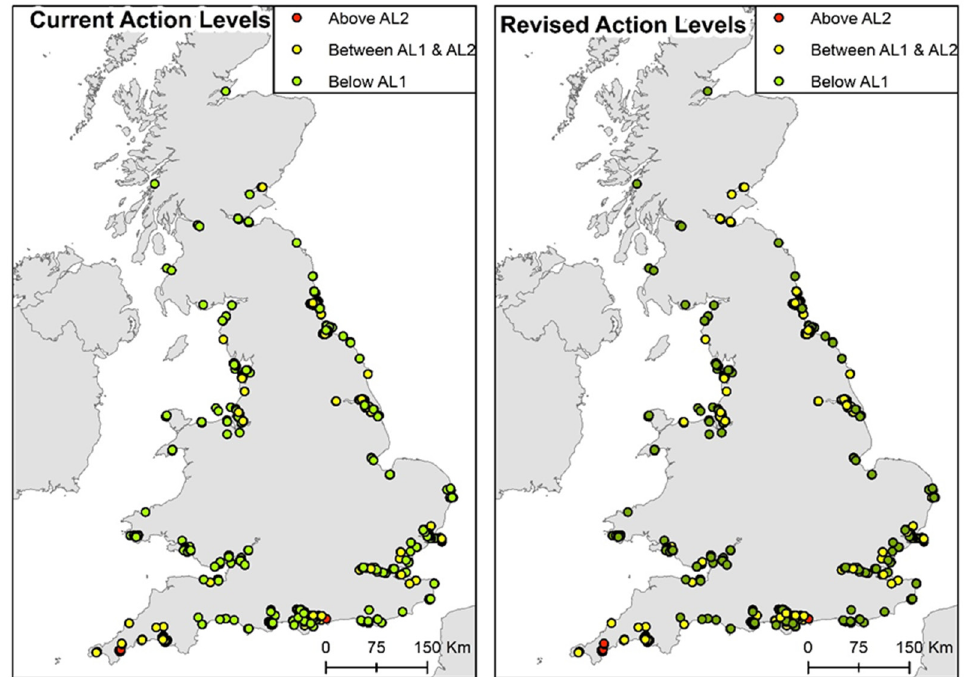
Figure 2. Maps showing the differences between the current ALs and revised ALs for copper (Cu). Samples above AL2 are indicated in red. Figure adapted from [13].